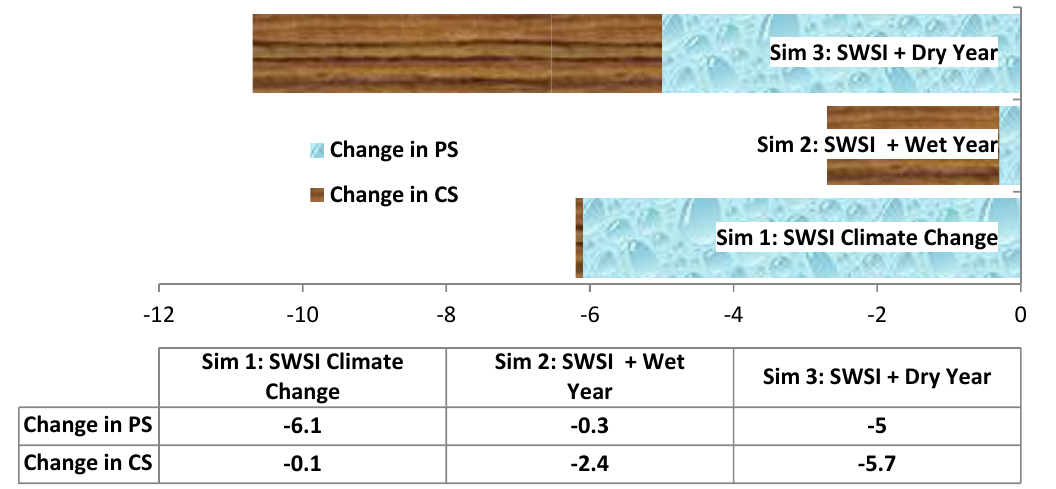
Figure 2. Changes in Producer Surplus (PS) and Consumer Surplus (CS), Million of